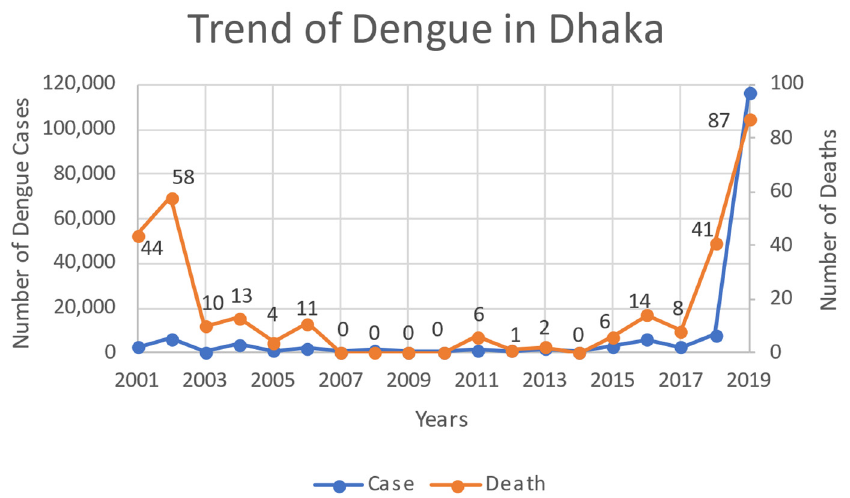
Figure 1. Distribution of dengue cases and number of deaths in the city of Dhaka, Bangladesh, 2001– 2019. (Source: Data procured from the Directorate General of Health Services (DGHS), Bangladesh, 2001–2013; Dhaka Tribune [27]; Shirin et al. [28]).